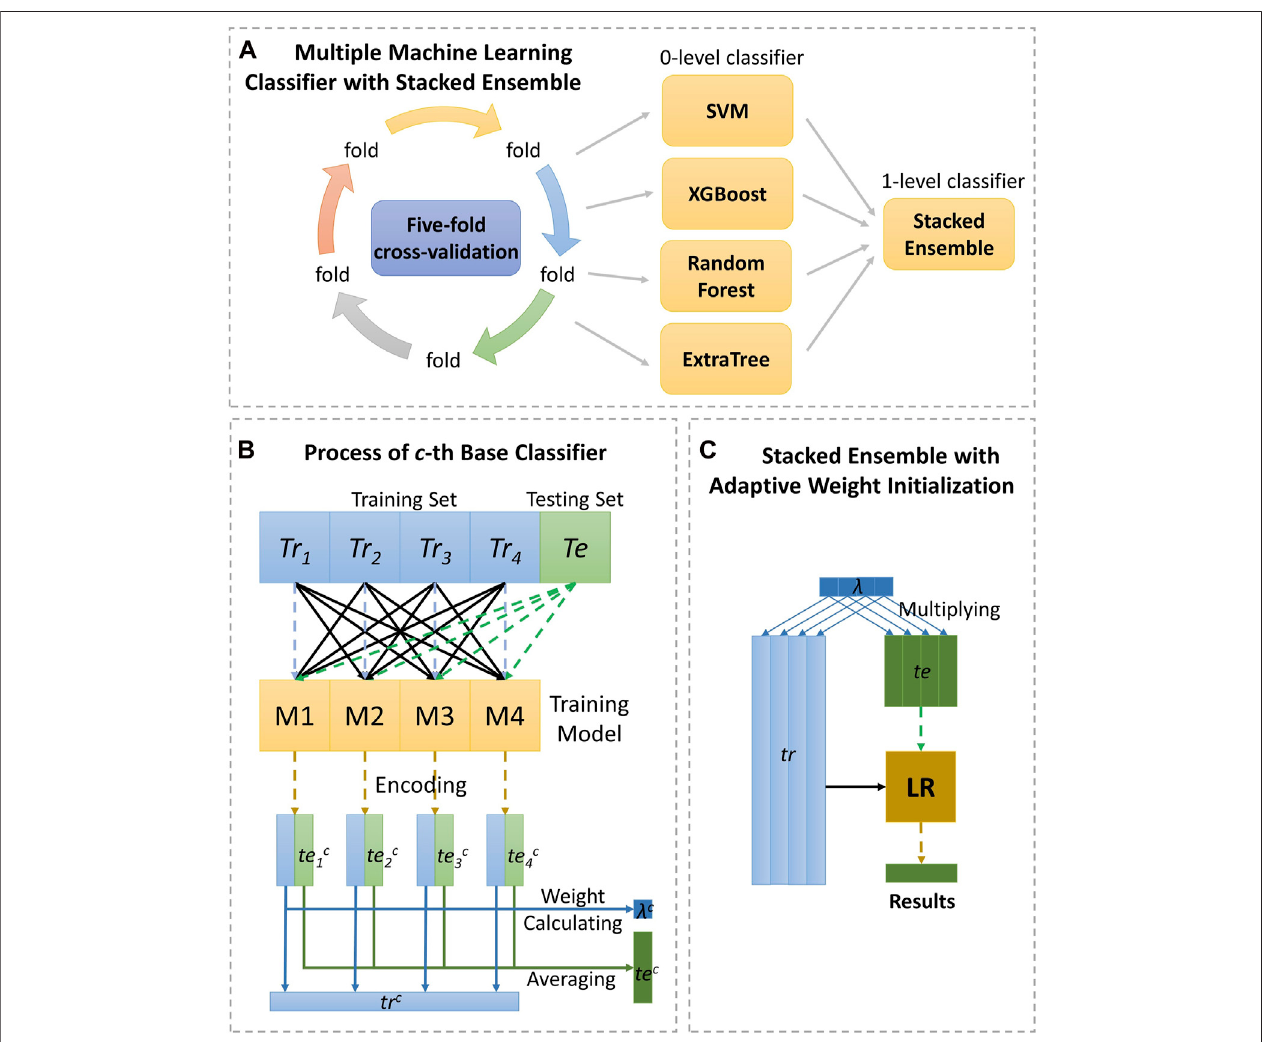
FIGURE 3 | The detailed process of the strategy, stacking ensemble with adaptive weight initialization. As (A) shown, the data are calculated by the four classi fi ers under fi ve-fold cross-validation, respectively and making fi nal prediction through stacked ensemble strategy. Section (B) displays the process of 0-level classi fi er, and section (C) displays the process of 1-level classi fi